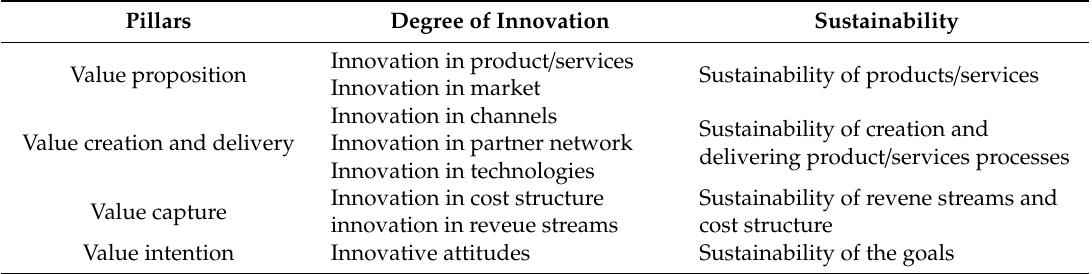
Table 6. Proposed business model of Barth et al. [79] for the agri-food